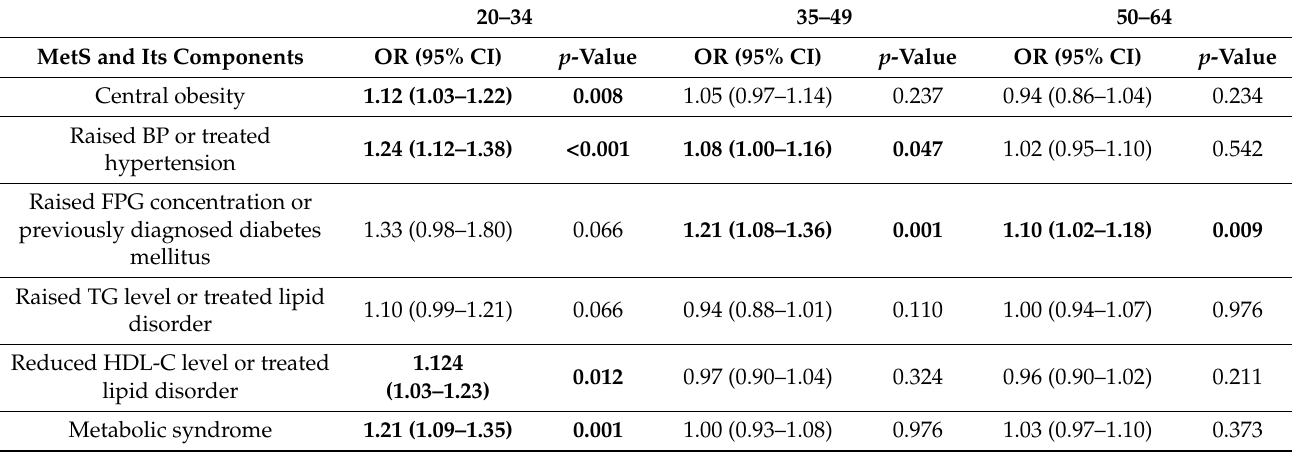
Table 4. The results of multivariate logistic regression models (adjusted by age and sex) to estimate the risk (OR—odds ratioand 95% CI—95% confidence interval) for metabolic syndrome and its components in the samples of 2018 compared to that of 2006 by age groups. The sample population of 2006 was used as